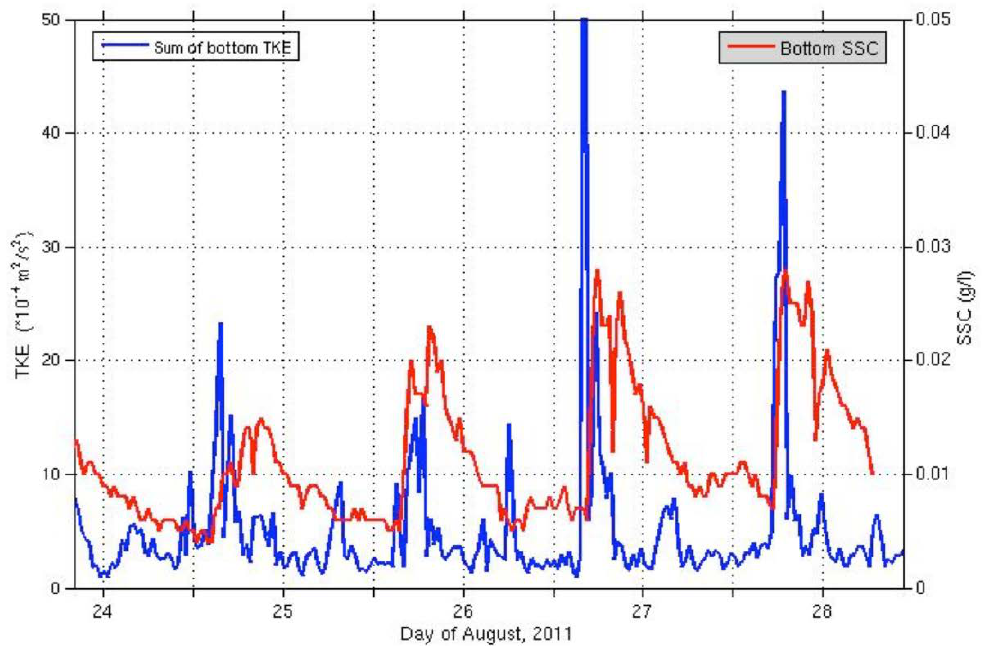
Figure 7. Comparison between the turbulent kinetic energy (TKE) and suspended sediment concentration (SSC) changes in the bottom boundary